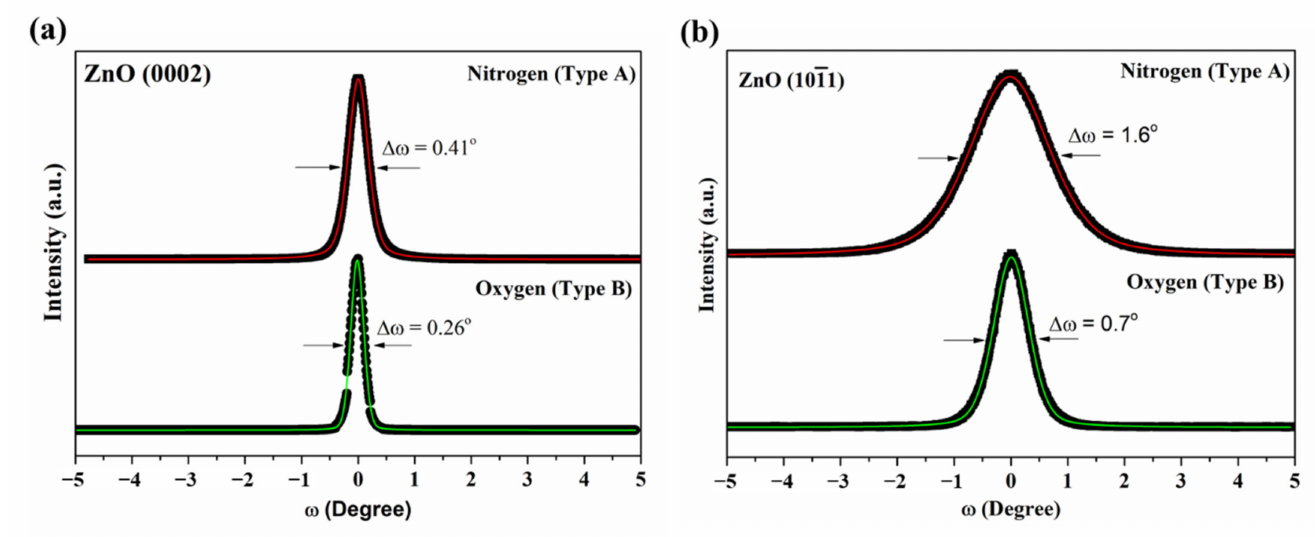
Figure 10. Rocking curve profiles of the ( a ) ZnO (0002) reflection and ( b ) ZnO (1011) reflection corresponding to ZnO layers hydrothermally grown on Type A and Type B seeds,